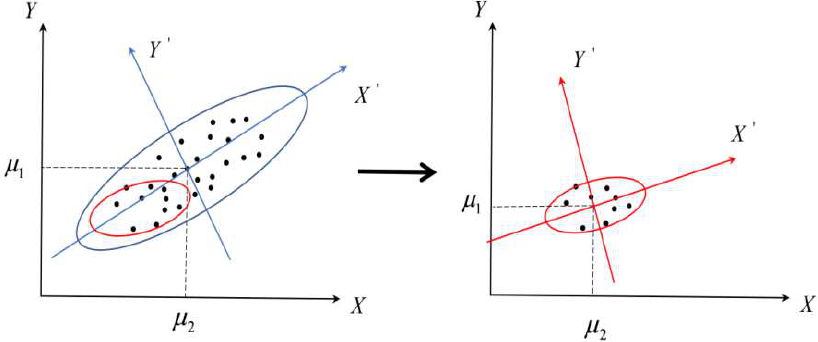
Figure 2. The PCA method based on the area to be tested.